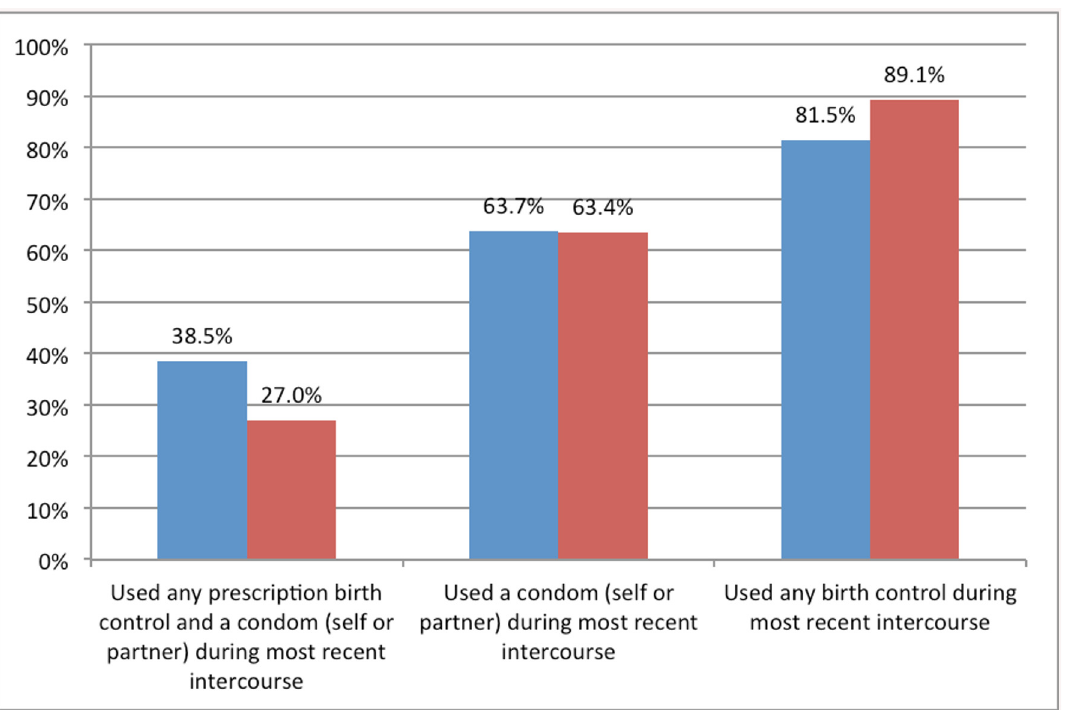
Fig 1. Use of contraception at last intercourse among participants aged 15 – 19: U.S. military population and National Survey of Family Growth. Blue Bars: Data from study population, n = 159. Red Bars: Data from National Survey of Family Growth 2006 – 2010, n =